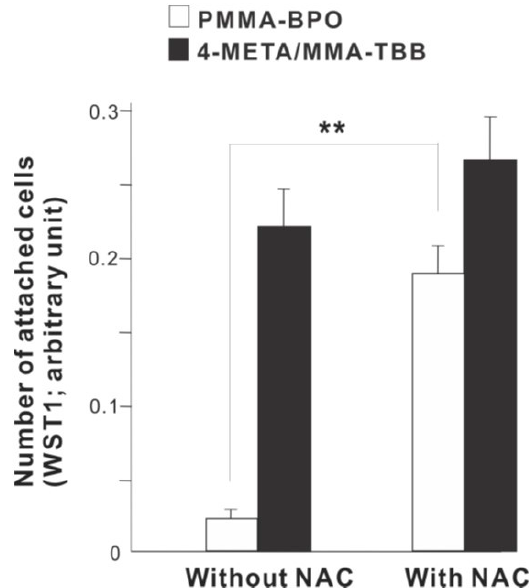
Figure 12. A rescue attempt of two different materials by incorporating anti-oxidant amino acid derivative, N-acetyl cysteine (NAC), into the materials examined by the ability of the materials to facilitate cell attachment. The number of osteoblasts attached 24 h after seeding evaluated by WST-1 assay is shown. ** p < 0.01, statistically significant difference.